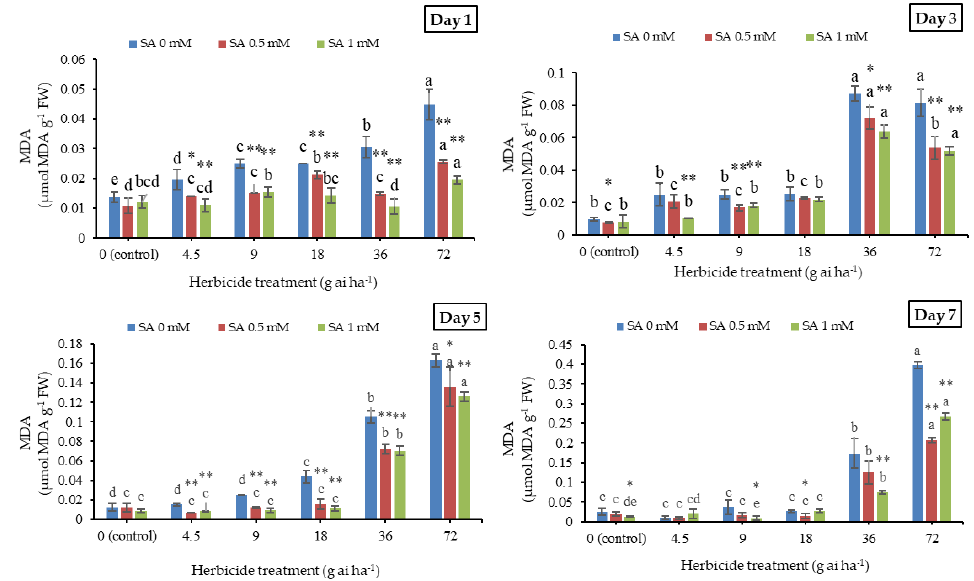
Figure 1. Changes in malondialdehyde (MDA) content in the leaf tissues of wheat at 1, 3, 5, and 7 days after herbicide application at different rates. The leaves were pre-treated with different con- centration of salicylic acid (SA) 3 days prior to herbicide application. The bars represent the treatment mean ± SD ( n = 4), and the bars with different lower-case letters were significantly ( p ≤ 0.05) different, according to the Duncan’s test. Asterisks indicate a significant difference between the herbicide only and herbicide with each concentration of SA, according to the Independent Samples t -test.